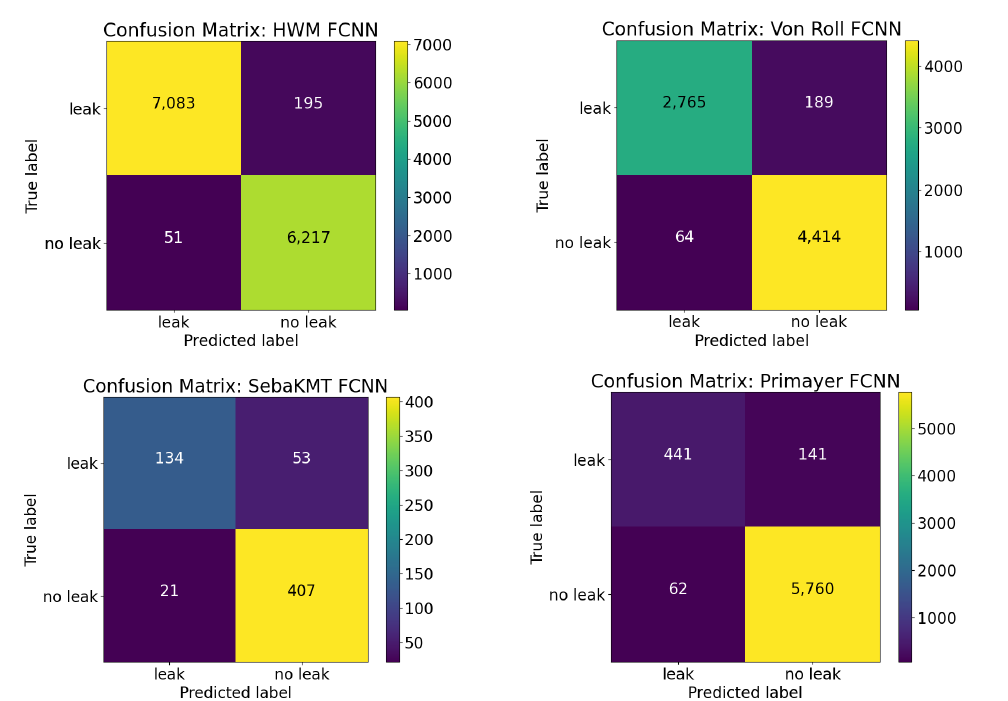
Figure 10. Confusion matrices for FCNN models. HWM ( top left ), Von Roll ( top right ), Seba KMT ( bottom left ) and Primayer ( bottom right